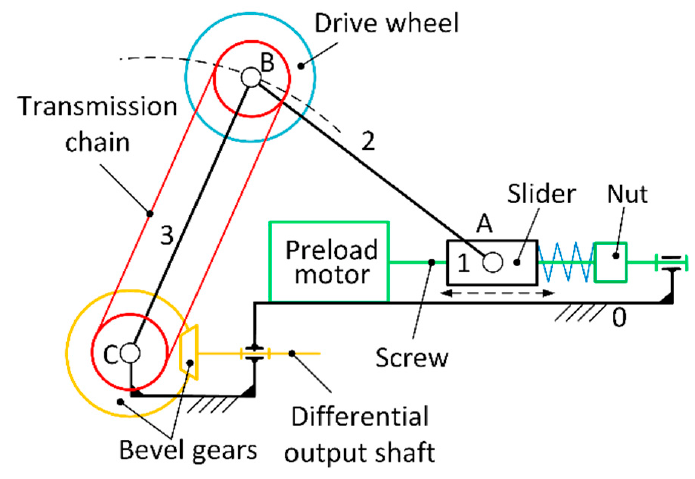
Figure 6. Mechanism for a self-adaptive pipe inspection robot.